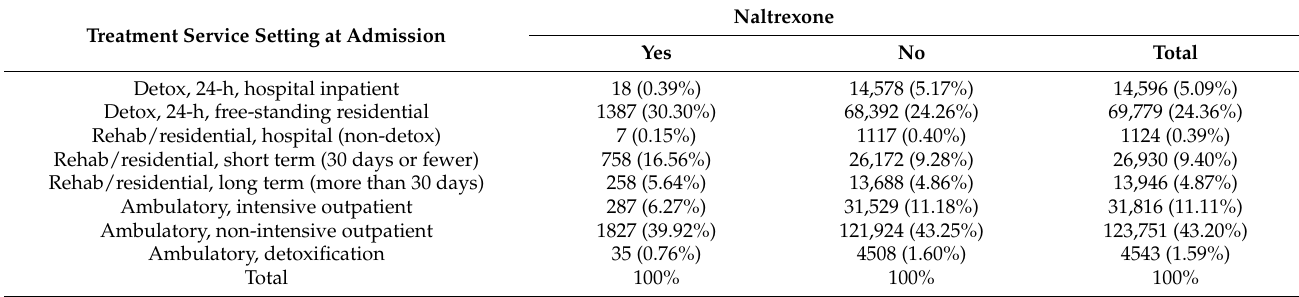
Table 3. Distribution of admissions for alcohol use disorder (AUD) clients from 2018 TEDS-A data across different treatment service settings at admission, by receipt of naltrexone.